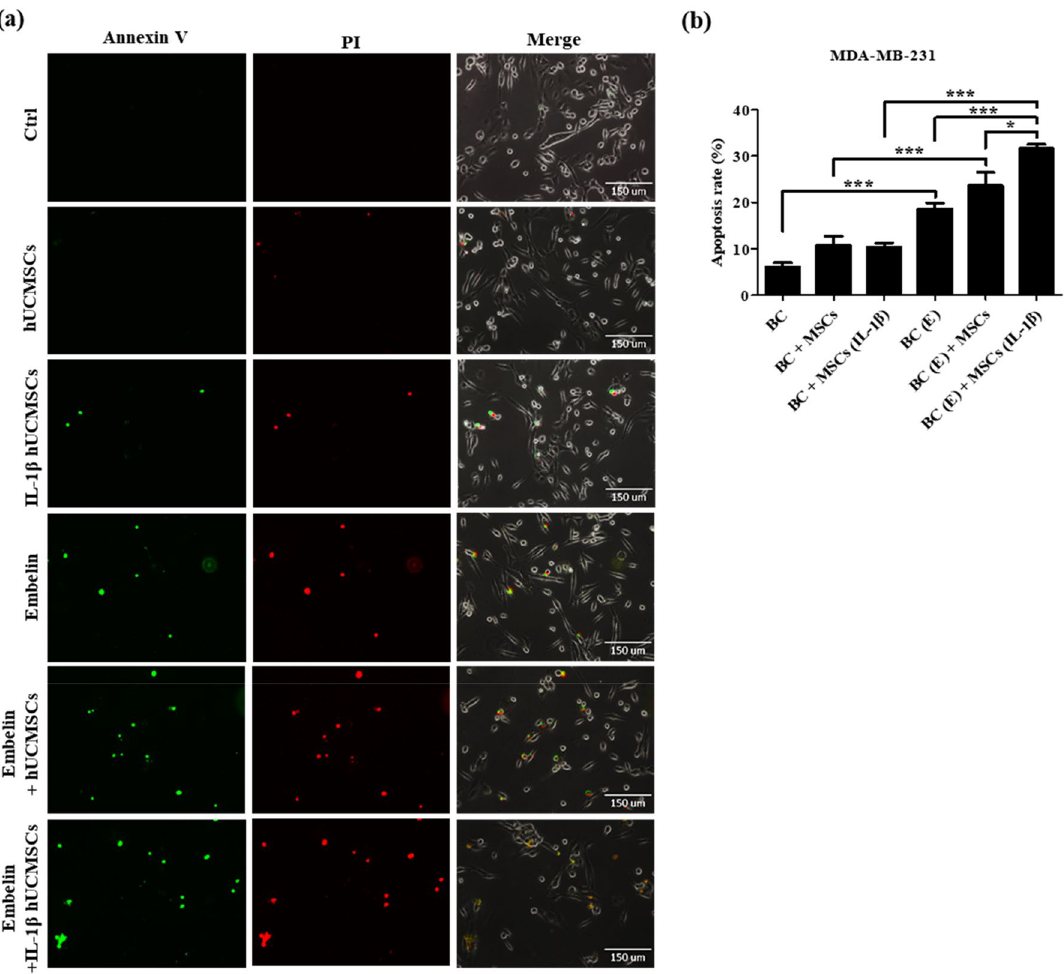
Figure 5. Embelin-treated breast cancer cells combined with IL-1β-stimulated hUCMSCs enhances the apoptosis of breast cancer cells. ( a ) MDA-MB-231, ( c ) MCF-7 and ( e ) MDA-MB-453 were pre-treated with or without 50 μM embelin and hUCMSCs were pretreated with or without 100 ng/ml IL-1β for 24 h. After co-culturing for 24 h, the expression levels of Annexin V (AV, green) and Propidium Iodide (PI, red) were detected by fluorescence microscopy. ( b , d , f ) The percentage of apoptotic cells was calculated by counting the AV+/PI−, AV+/PI+ expressing cells and total cell numbers. Data were shown as mean ± SEM and analyzed by one-way ANOVA with Dunnett’s test. (n = 3, * P < 0.05, ** P < 0.01, *** P < 0.001) (BC = untreated breast cancer cells, MSCs = hUCMSCs, BC (E) = breast cancer cells pretreated with 50 μM embelin, MSCs (IL-1β) = hUCMSCs pretreated with 100 ng/ml